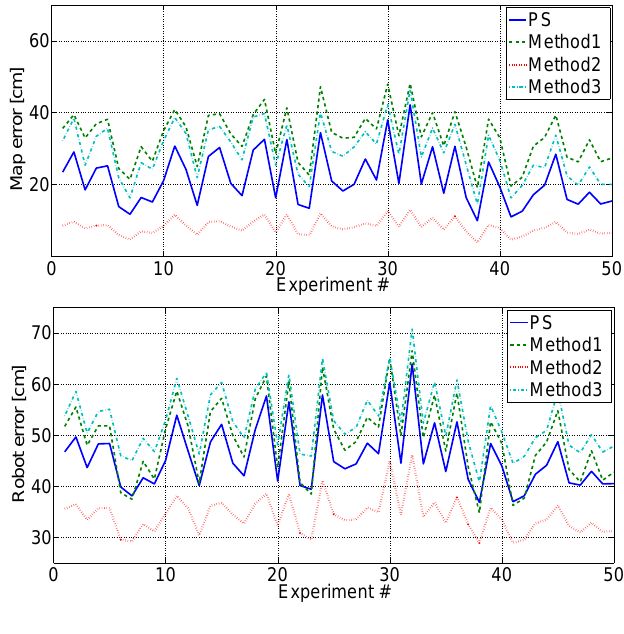
Figure 13. Mean beacon initialization times ( top ) and computational times ( bottom ) required in each of the 50 experiments performed with Method1 , Method2 , Method3 and the proposed scheme (PS).